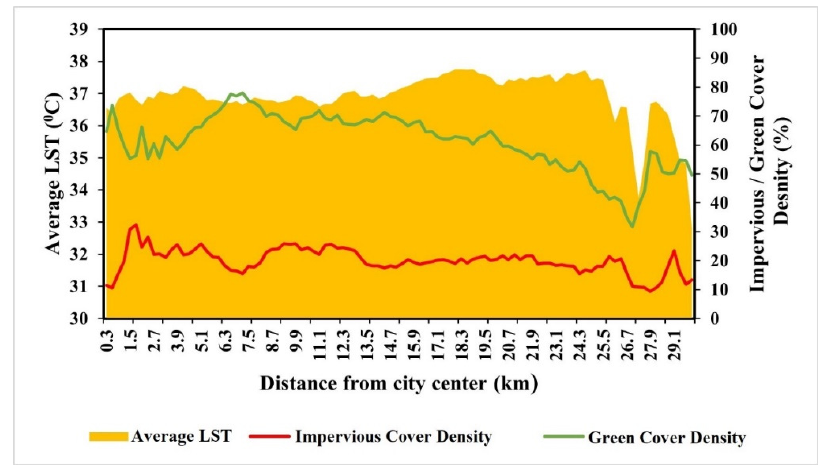
Figure 5. Variation of actual average land surface temperature (LST) and impervious and green cover density along urban rural gradient.